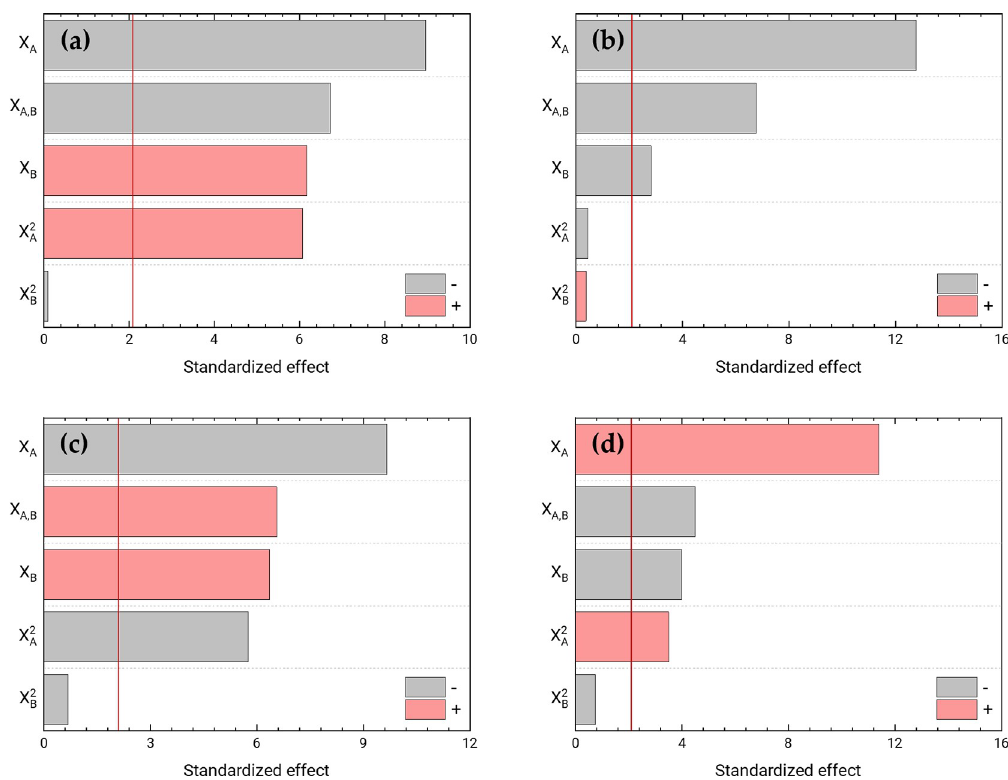
Fig 5. Pareto charts. Analysis of the effects of the central composite factorial design. Pareto charts with standardised effects of two experimental factors, in decreasing order of importance (in absolute value) for the Z-average diameter ( a ), zeta-potential ( b ), PdI ( c ), and entrapment efficiency ( d ). The vertical red lines represent the threshold of significance ( P = 0.05) for 20 degrees of freedom.